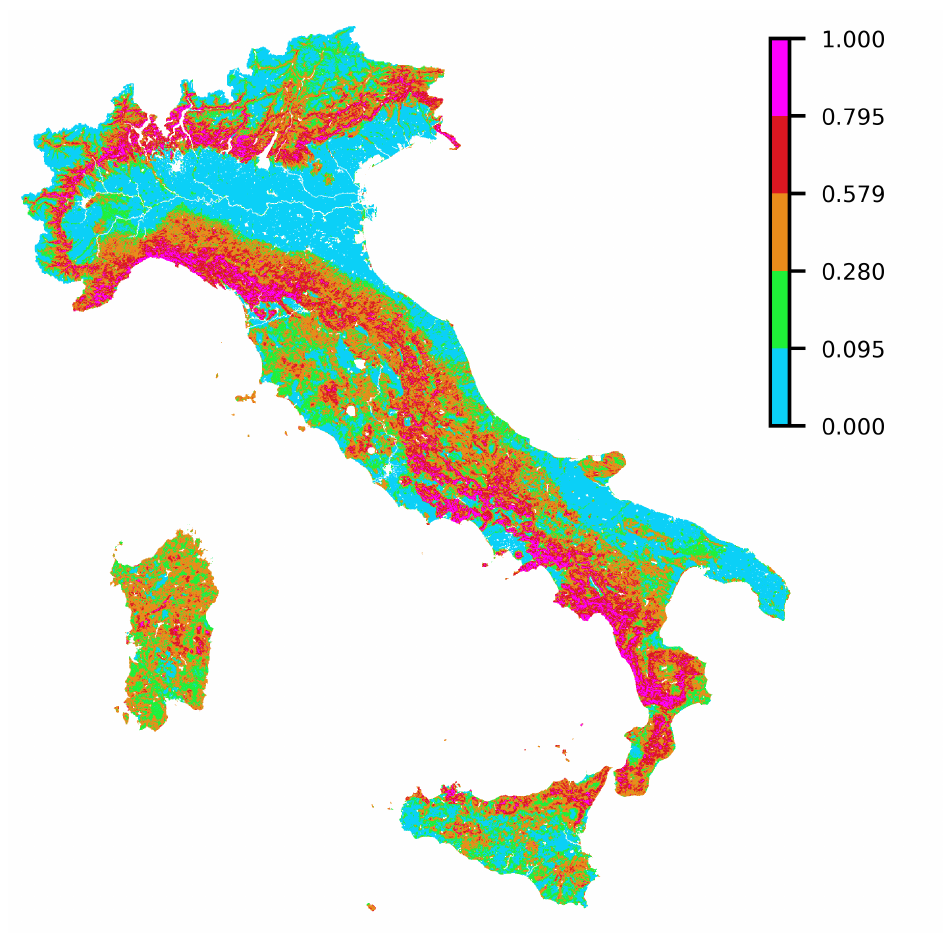
Figure 16. Susceptibility map for the winter fire season. To build the color palette, the continuous susceptibility values referred to the following percentiles have been calculated: 30–50–80–95. The color palette is therefore composed of five classes delimited by the susceptibility values of the following percentile class: blue (0–30), green (30–50), orange (50–80), red (80–95), purple (95–100). As for the summer case, the computed numerical values are reported in the colorbar.